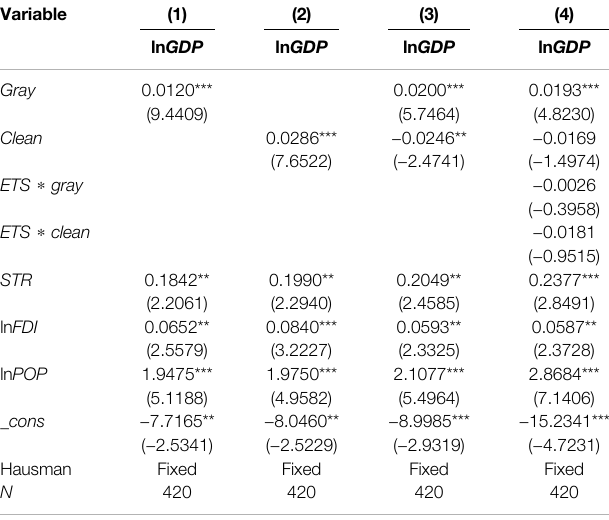
TABLE8| Economiceffectsoftwokindsoflow-carbontechnologicalinnovations.